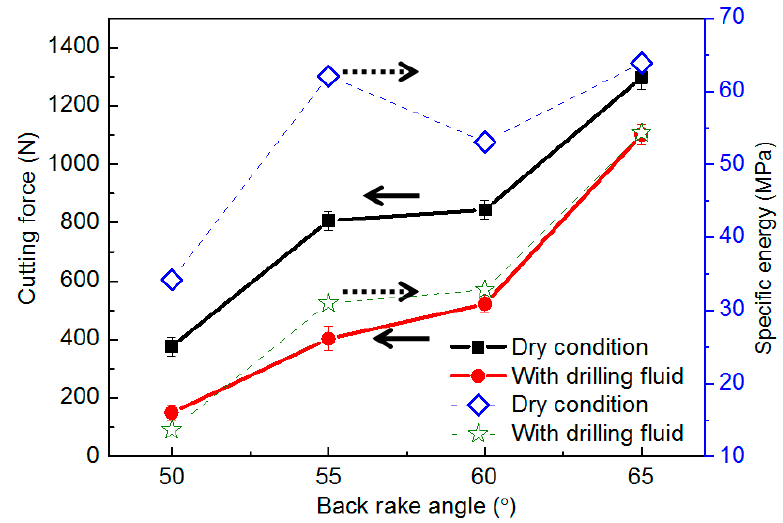
Figure 8. Variation of cutting force and specific energy with back rake angle at a constant cutting depth of 1 mm. Solid symbols are cutting force results and hollow symbols stand for results of specific energy.